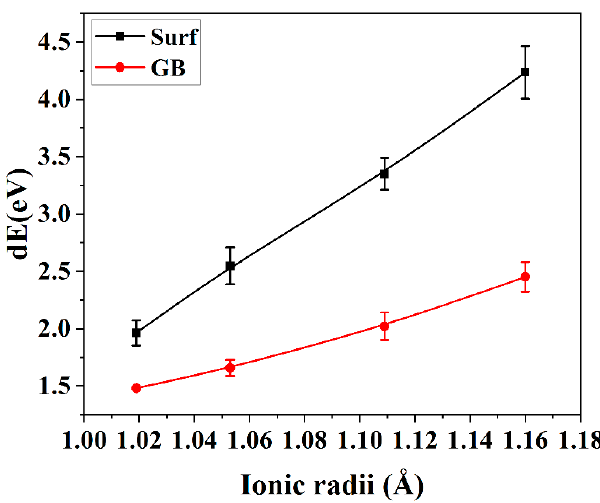
Figure 9. The differences between the grain boundary energy and surface energy in rare earth ‐ doped ZrO 2 .